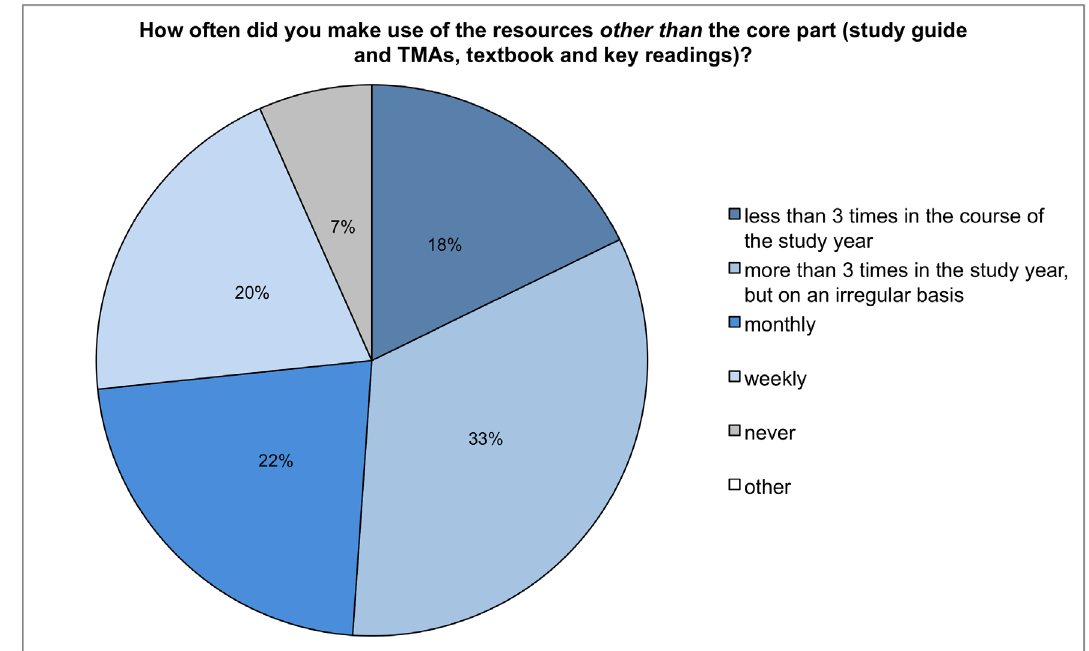
Figure 5 . Frequency of student use of extra, non-examinable resources